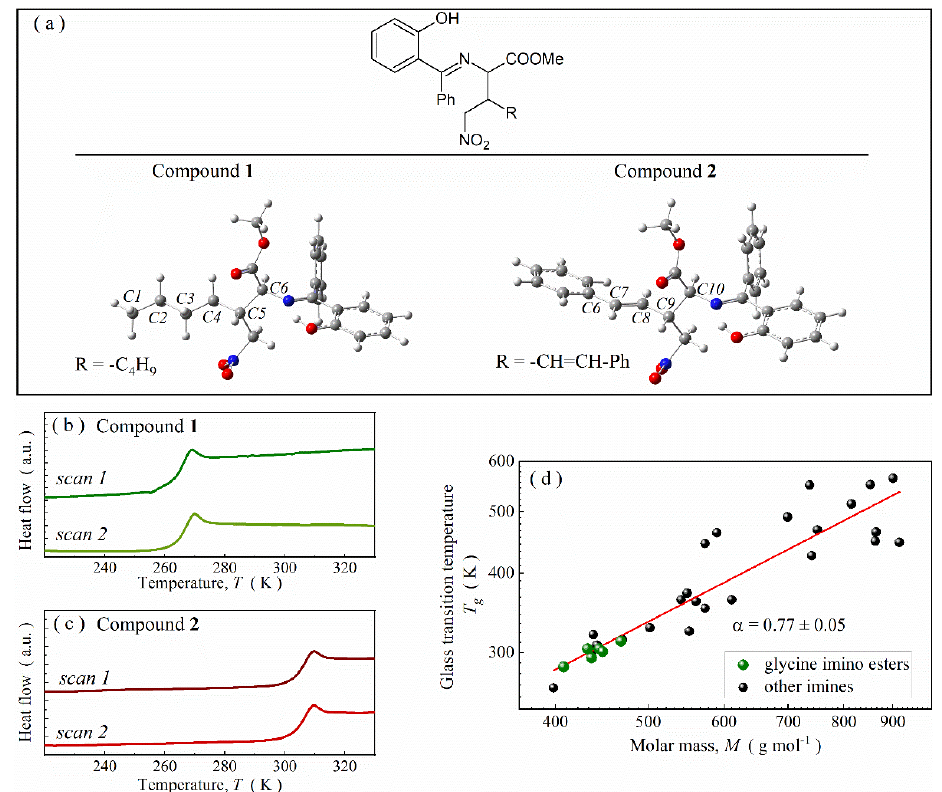
Figure 1. ( a ) The structure of glycine imino ester molecules of particular interest with labeled most crucial carbon atoms for conformational analysis. ( b ) Outcome of two subsequent calorimetric heating scans for compound 1 . ( c ) Thermograms for compound 2 . ( d ) Correlation between molar mass and glass transition temperature for imines.